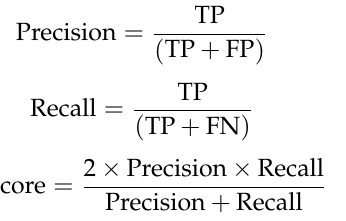
Table 1. BCCD dataset.